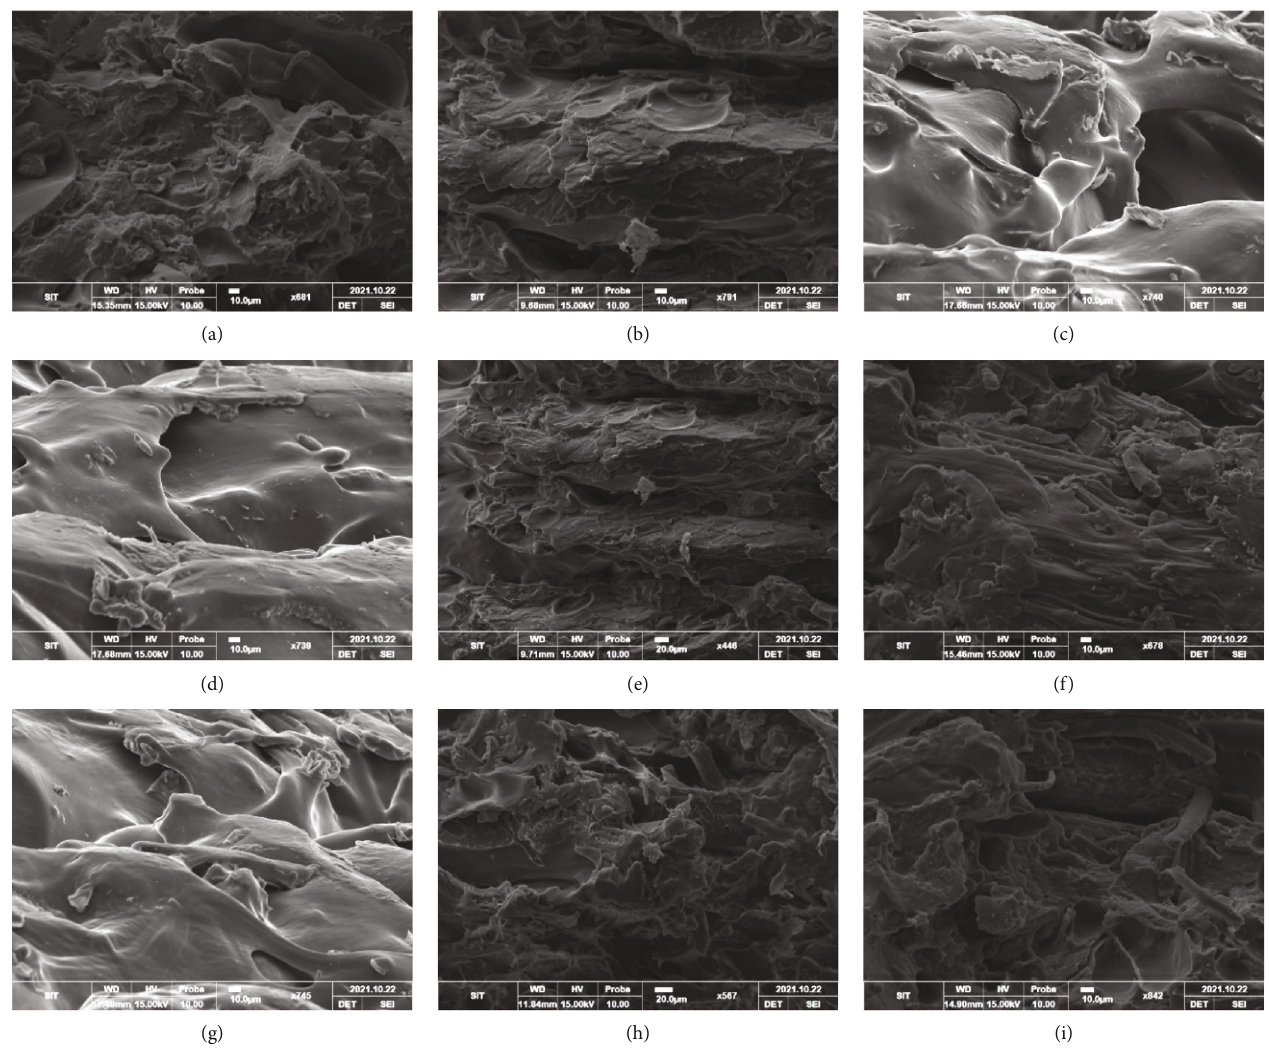
Figure 5: Micrographs of tensile fractography according to Table